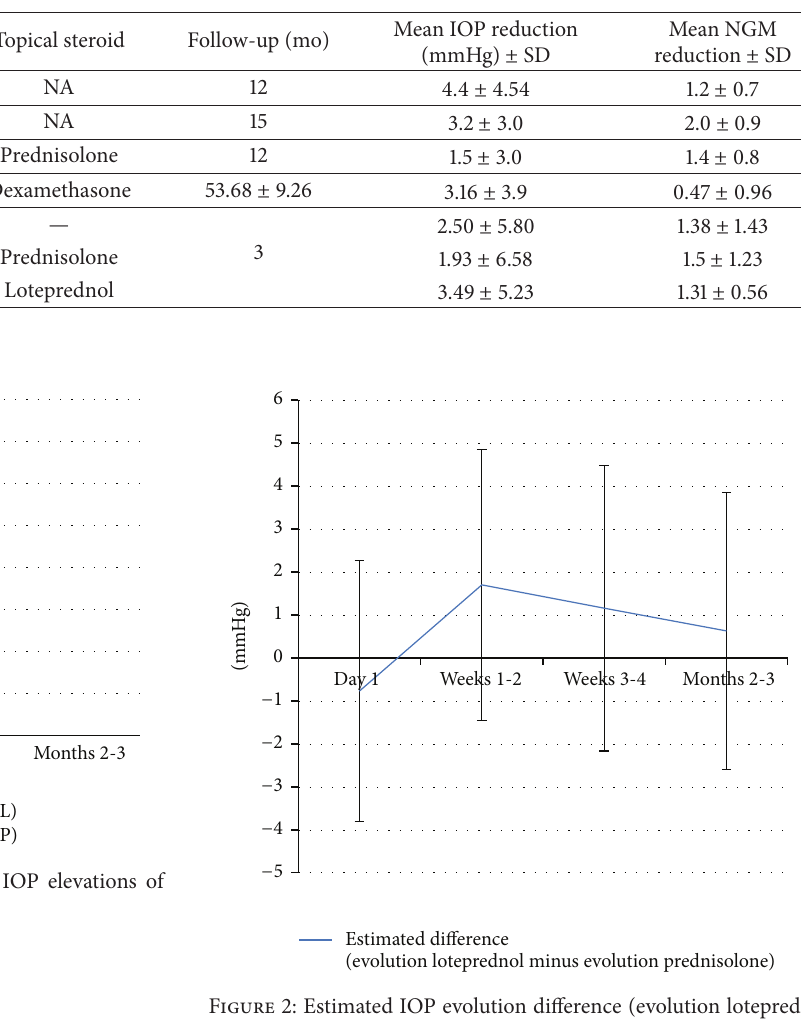
Table 2: IOP and NGM reductions reported in previous studies and current study.